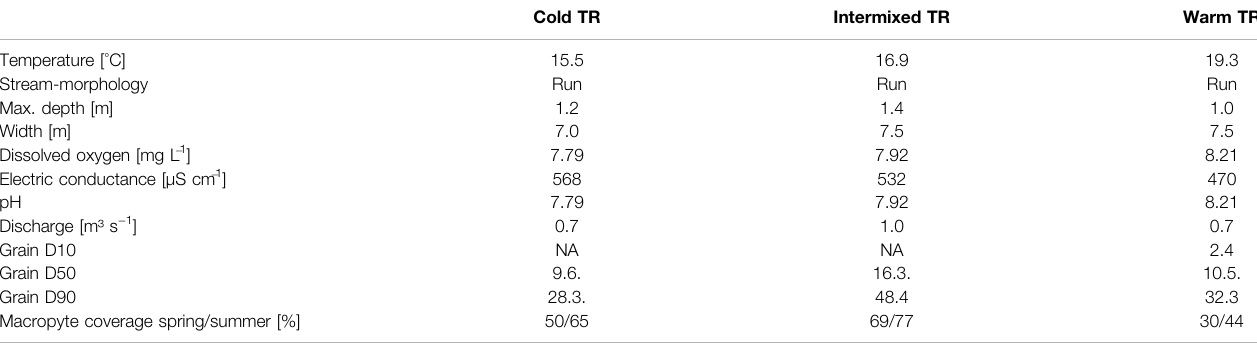
TABLE 1 | Characterisation of the three different thermal regions (TR) cold, intermixed and warm. Temperature, dissolved oxygen, pH and electric conductance are given as means.